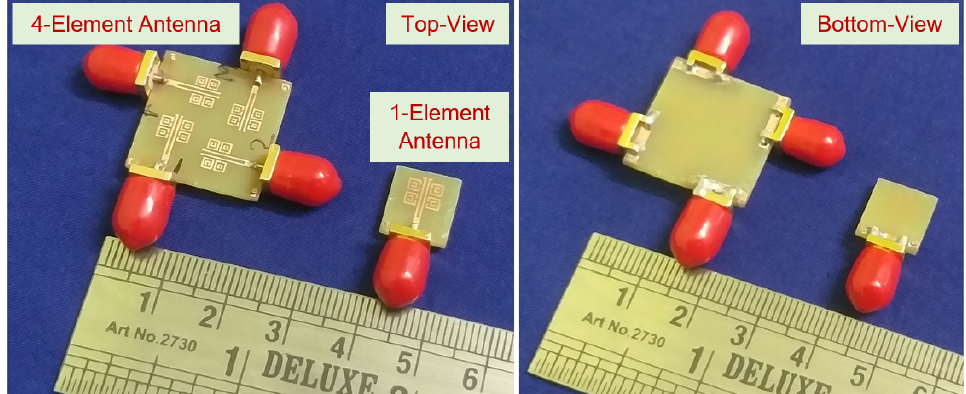
Figure 25. The fabricated prototypes of the one-element antenna and four-element antenna configu- rations with their alternate